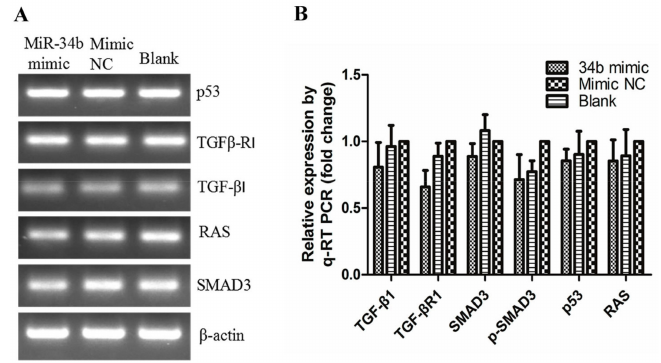
Figure 10. Transcript levels of TGF- β 1, TGF β -R1, SMAD3, p53 and RAS after treatment with 50 nM miR-34b mimic, NC mimic in PC3 cells by PCR ( A ) and qRT-PCR ( B ) β -actin was used as an internal control. The mRNA expression of genes was not significantly different in PC3 cells treated with or without miR-34b mimics. Per condition, three independent experiments were performed. TGF: transforming growth factor; SMAD: mothers against decapentaplegic; p53: a phosphorylated protein with a molecular weight of 53,000; RAS: rat sarcoma.